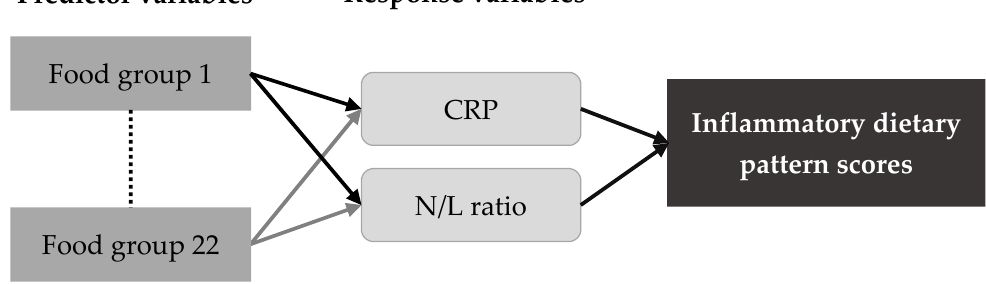
Figure 1. The dietary pattern derived from the reduced rank regression model. CRP: C-reactive protein, N/L: neutrophil-to-lymphocyte.